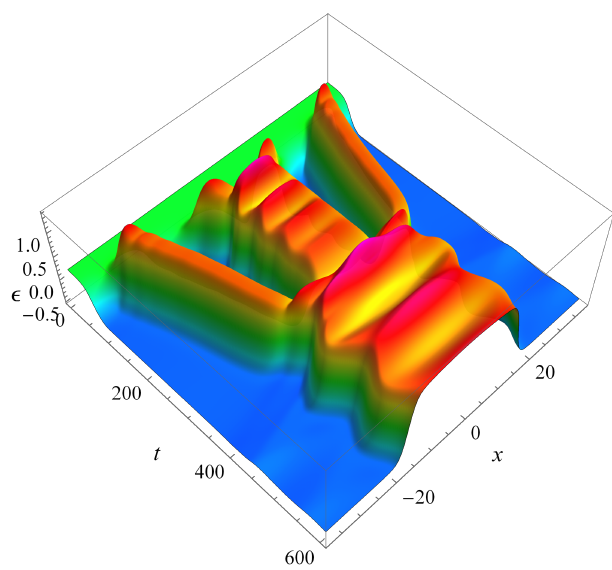
Figure 2. In the spinodal region, any arbitrarily small perturbation will drive the system to a final phase-separated state [11] (see also [12, 13, 17]). For instance, in this plot, the initial state with { T, s } = { 0 . 25 , 2 . 77 } is perturbed by a Gaussian-like perturbation in the form of δφ = (cid:2) (cid:0) x (cid:1)(cid:3) − 0 . 1 r − 4 ( r − 1) 2 exp − 10 cos 2 , and the subsequently nonlinear evolution of the energy density 24 possesses a final phase